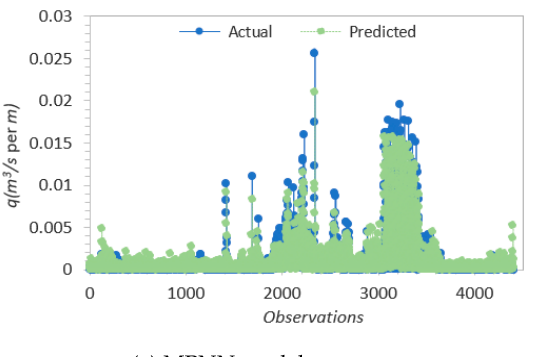
Table 5. Optimal sigma values for each input parameter of the GRNN model.